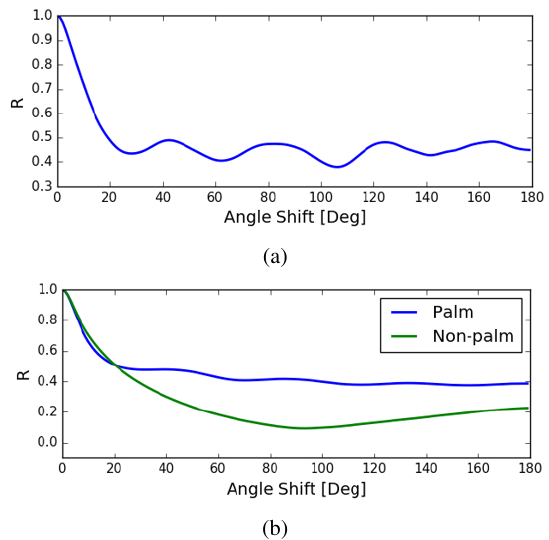
Figure 9: (a) CAPS of a palm sample (b) Average CAPS of all palm and non-palm training samples